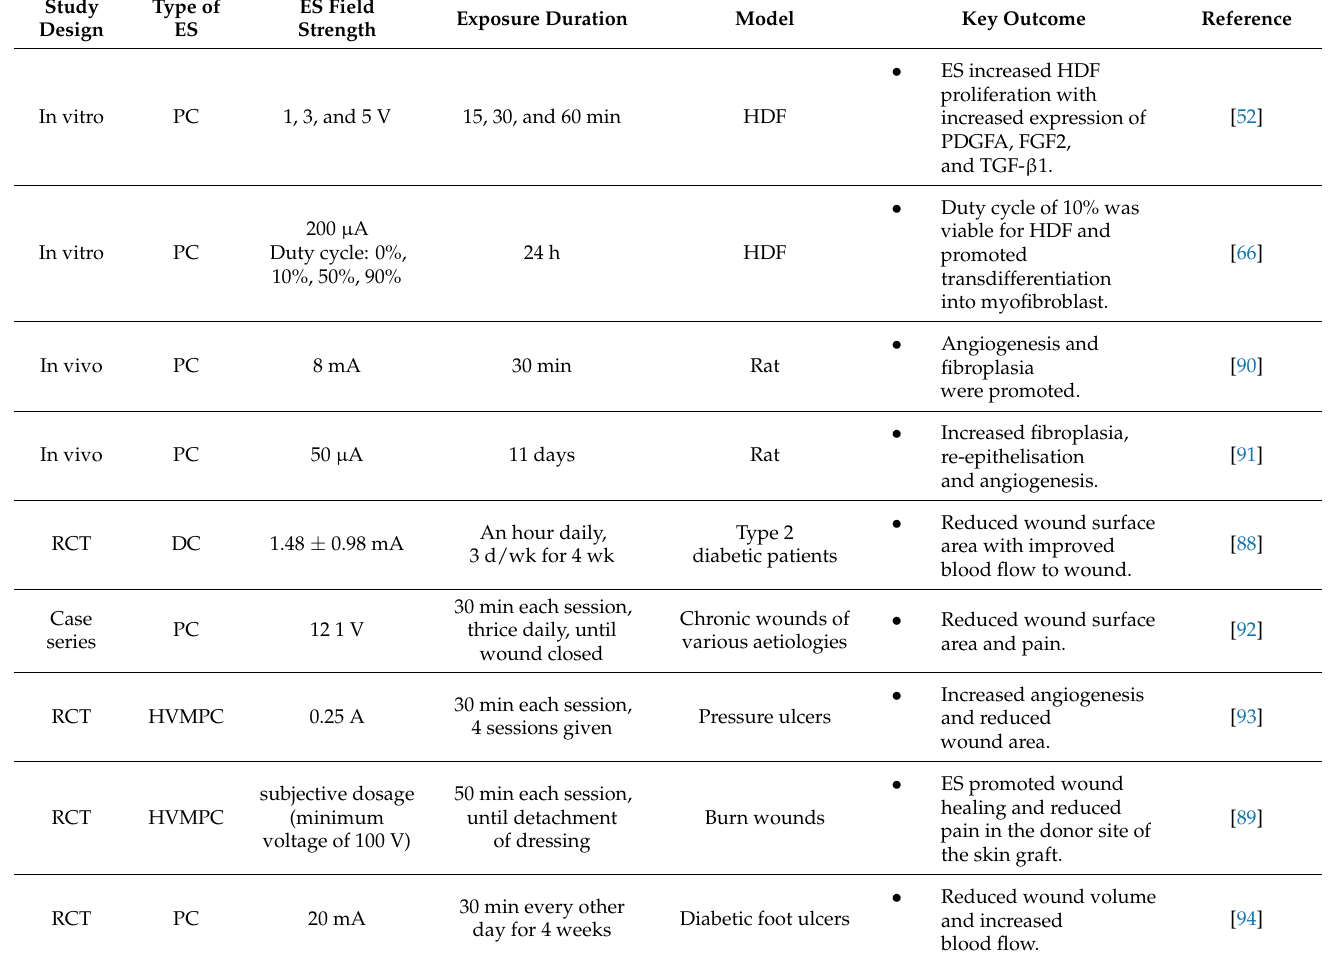
Table 1. Key outcomes of various ES studies.